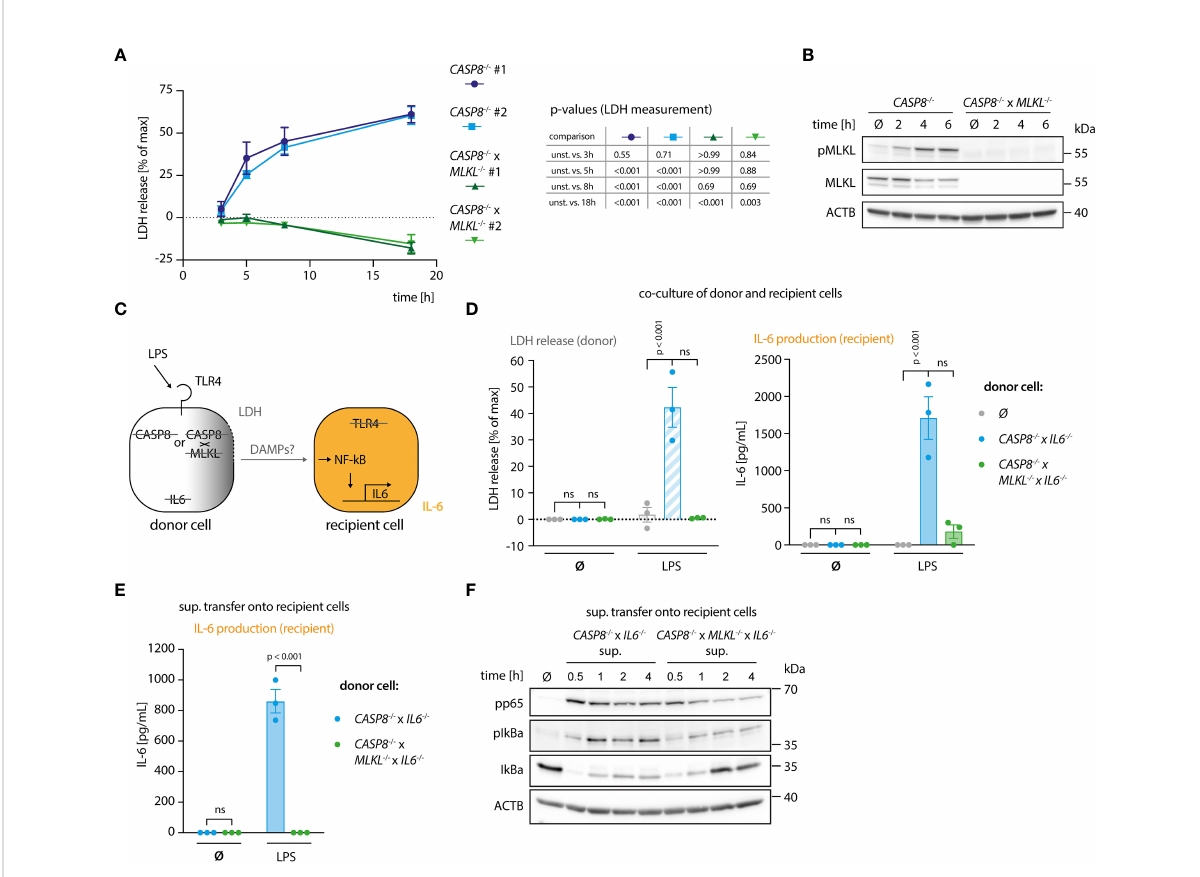
FIGURE 1 A genetic system to study necroptosis-dependent in fl ammation. (A) BLaER1 cells of the indicated genotypes were stimulated with 2 ng/ml LPS as indicated and LDH release was determined. (B) CASP8 -/- and CASP8 -/- x MLKL -/- BLaER1 macrophages were stimulated with 2 ng/ml LPS for the indicated times. Cell lysates were blotted for the indicated proteins. (C) Schematic overview of the system of donor and recipient BLaER1 cells generated to perform co-culture and supernatant transfer experiments. (D) Cells of the indicated genotypes were co-cultured in a 1:1 ratio with TLR4 -/- recipient cells (grey dots = recipient cells only) and stimulated with 2 ng/ml LPS for 18 h LDH release and IL-6 production were determined. (E) Donor cells were stimulated with 2 ng/ml of LPS for 18 h The supernatant was then collected and used to stimulate TLR4 -/- recipient cells for 24 h and IL-6